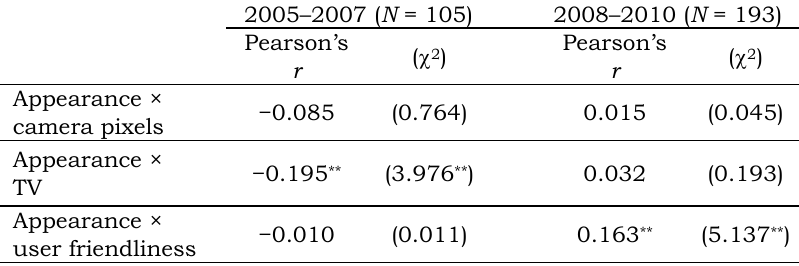
Table 1. Summary of cross